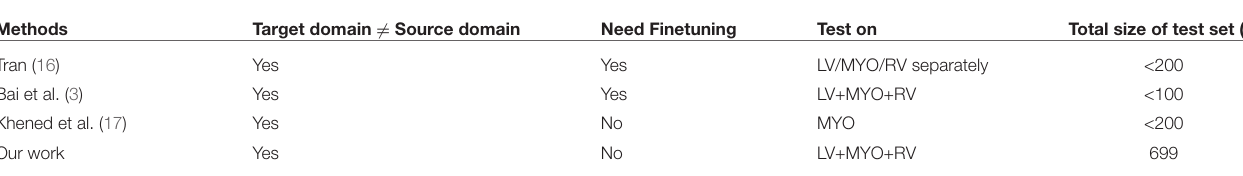
TABLE 1 | Related work that applies CNN-based CMR image segmentation models across multiple datasets.